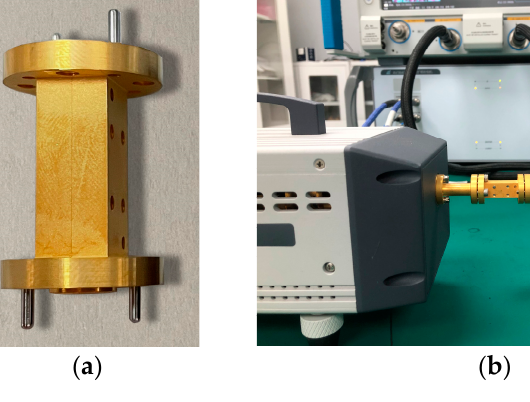
Figure 4. First fabricated 340 GHz terahertz filter: ( a ) fabricated terahertz filter; ( b ) testing environ- ment; ( c ) simulation and measured results.